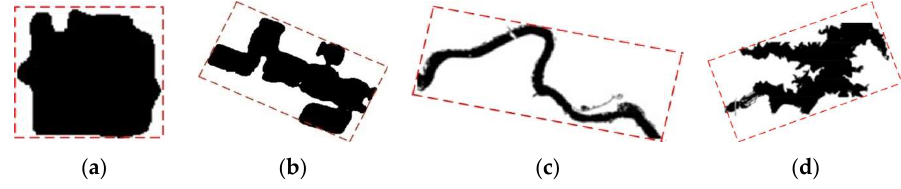
Figure 2. The demonstration of the weighting of smoothness within the objects. ( a ) Single paddy field; ( b ) connected paddy fields; ( c ) river; ( d ) lake.